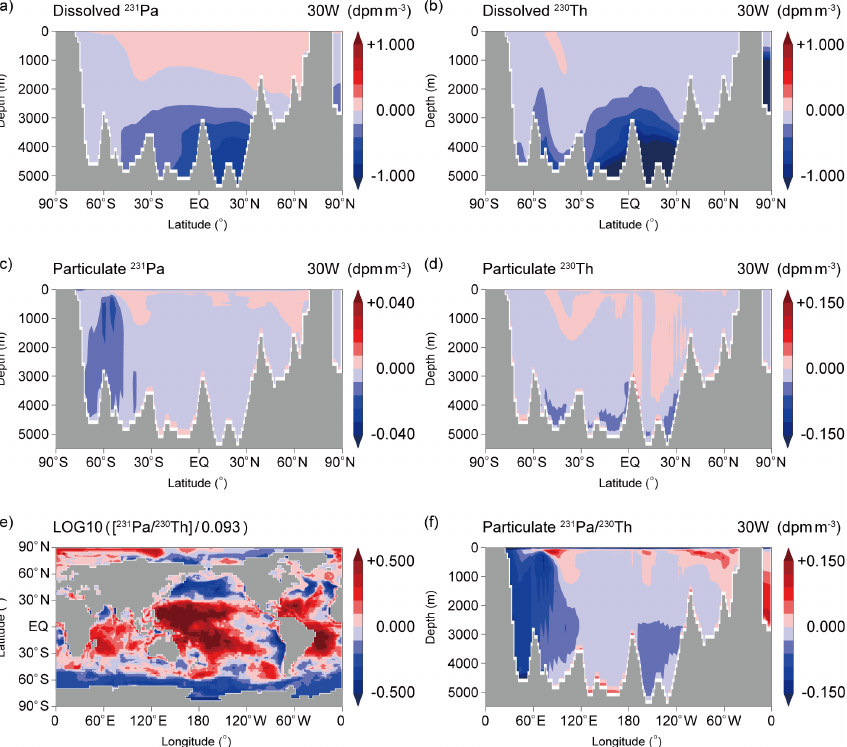
Figure 8. The difference between CTRL_EXP and 3D_EXP (i.e., CTRL_EXP minus 3D_EXP, which represents for bottom scavenging effect) of (a) dissolved 231 Pa, (b) dissolved 230 Th, (c) particulate 231 Pa, and (d) particulate 230 Th along 30 ◦ W in the Atlantic Ocean. (e) The difference between CTRL_EXP and 3D_EXP of the sedimentary 231 Pa / 230 Th ratios is normalized by the production ratio of 0.093.